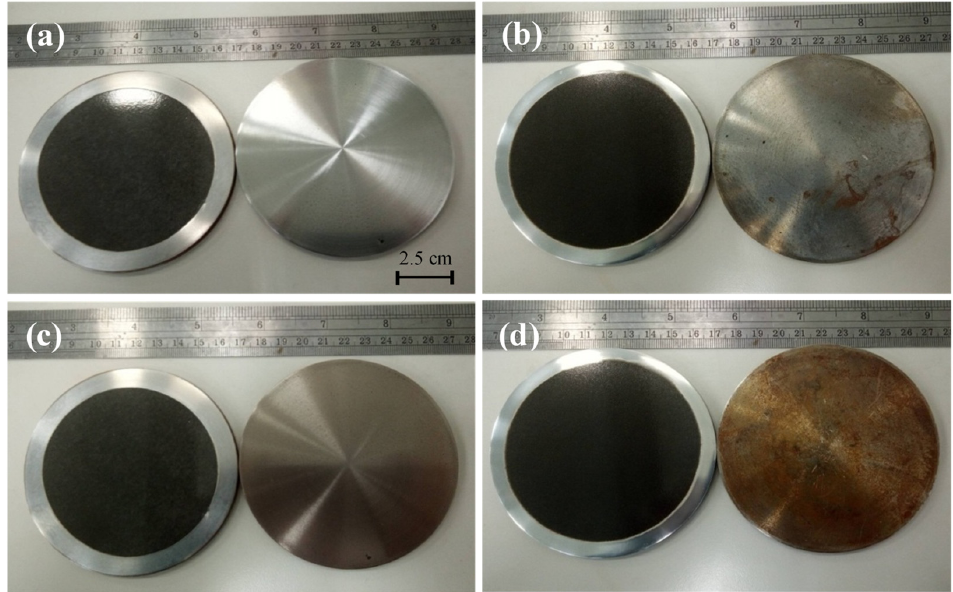
Figure 13. Actual photos of surface changes on AISI 1045 steel with (left side) and without (right side) hard anodization in HCl gas atmosphere after ( a ) 30 sec, ( b ) 0.5 h, ( c ) 10 h, and ( d ) 24 h.